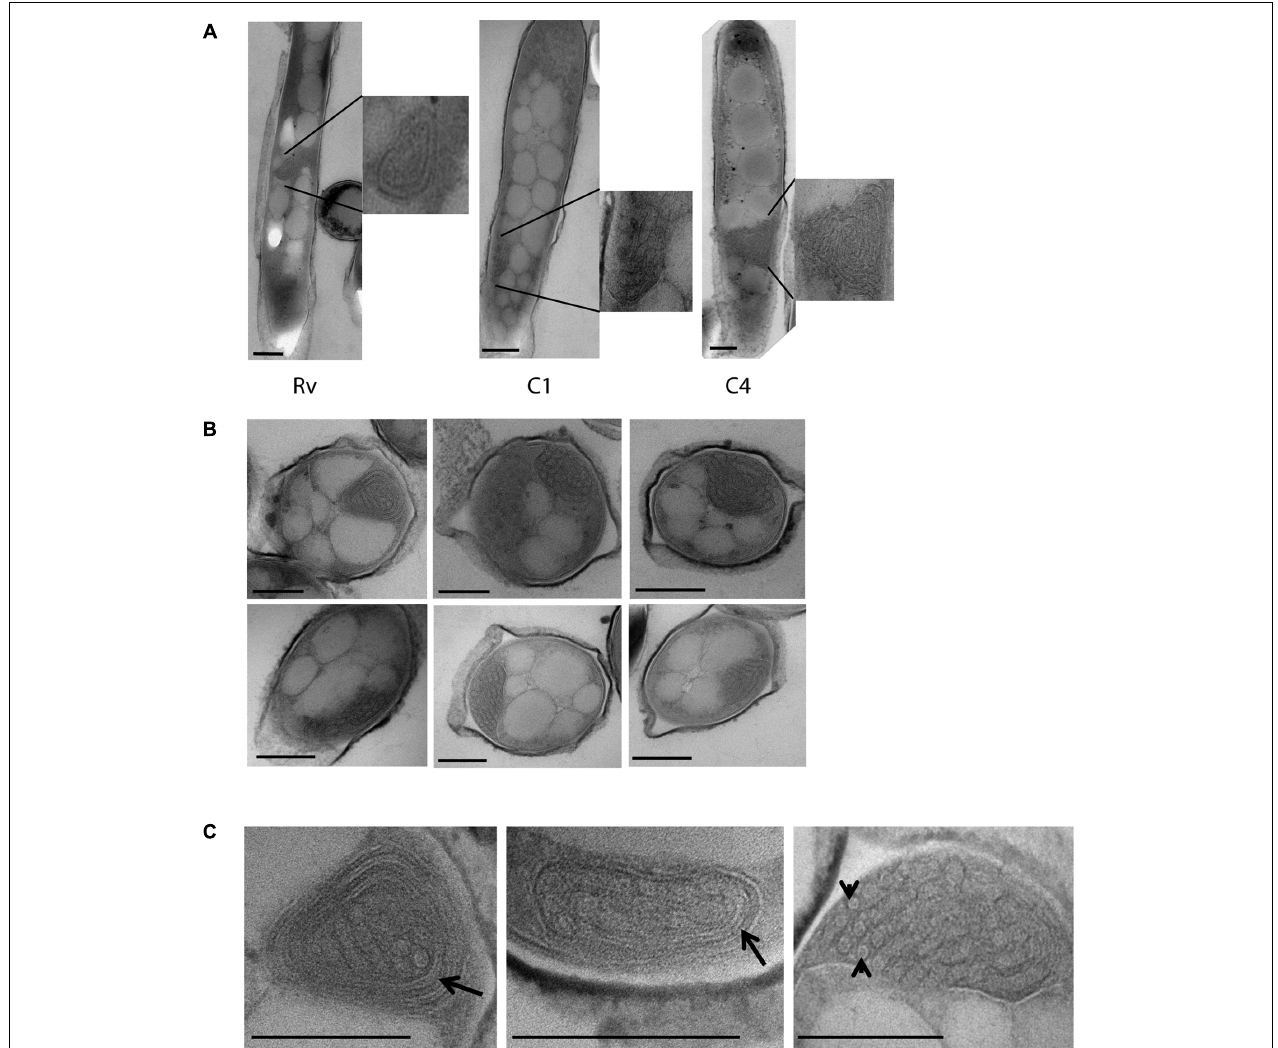
FIGURE 5 | Cytoplasmic compartments in M. tuberculosis strains under iron deficiency. (A) H37Rv (Rv) and clinical M. tuberculosis strains (C1, C4) grown under 500 µ m DFO, displaying cytoplasmic compartments in cells along with enlarged images. (B) Multiple sections of M. tuberculosis cells grown under 500 µ m DFO, with cytoplasmic compartment as indicated by asterisks. (C) Higher magnification images (40–50 K X) of cytoplasmic compartments from M. tuberculosis cells grown under 500 µ m DFO, arrow indicates membrane-like structures surrounding the cytoplasmic compartment and arrowhead indicates subunits assembled inside the compartment. DFO, deferoxamine mesylate salt; scale bar = 200